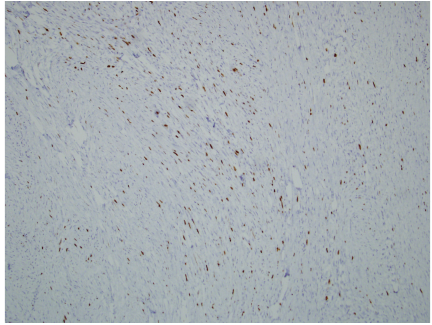
Figure 9: Ki 67 proliferative index of 10% per 10 HPF in MTNST.